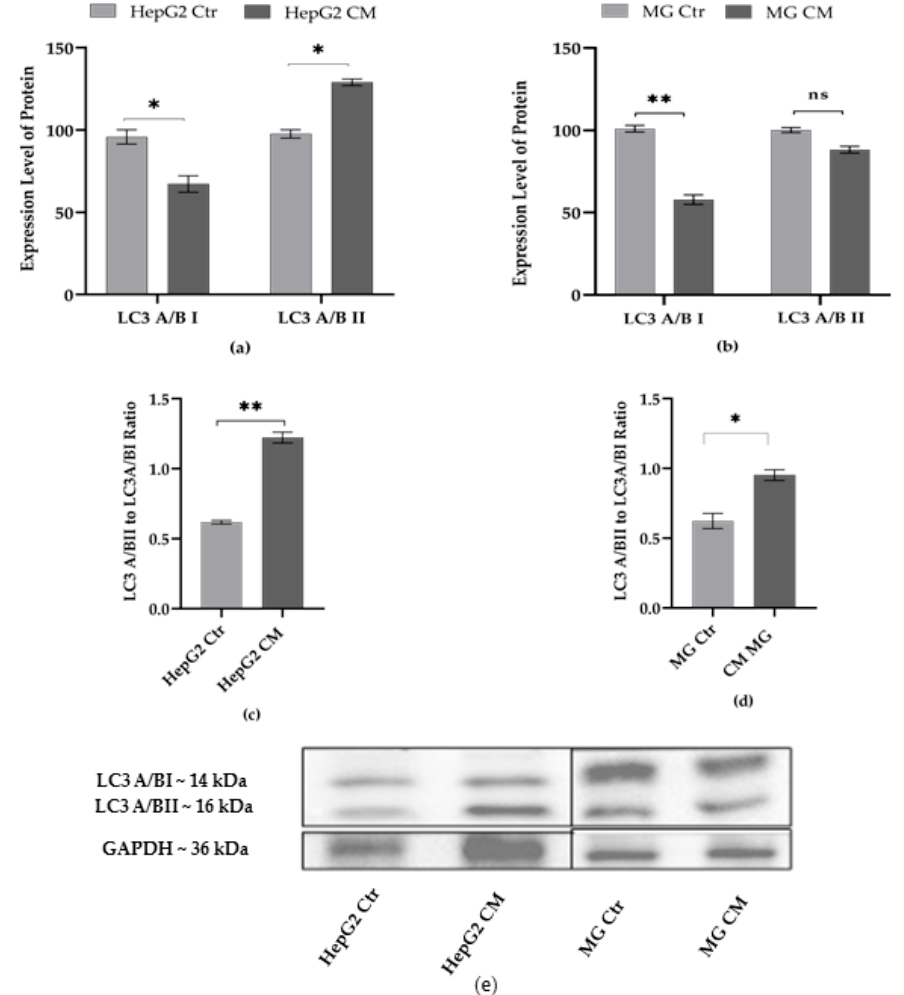
Figure 4. Effect of conditioned media on protein levels of LC3 A/B I and LC3 A/B II. The protein levels of ( a ) HepG2 and ( b ) HMC-III (MG) cells were normalized with GAPDH content; then, for each cell type grown in conditioned medium (CM), data refer to the corresponding control cells grown in their own culture medium (Ctr), set to 100%. ( c , d ) The LC3II/I ratio for each cell types. ( e ) Representative western blots. Densitometric analysis of the immunoreactive bands performed in three independent experiments and results are expressed as the mean ± the standard error. Statistical analysis was performed by using t -test; * p <0.05, ** p <0.01; control (Ctr) cells vs. media conditioned treated (CM) cells; ns: not significant p -value.